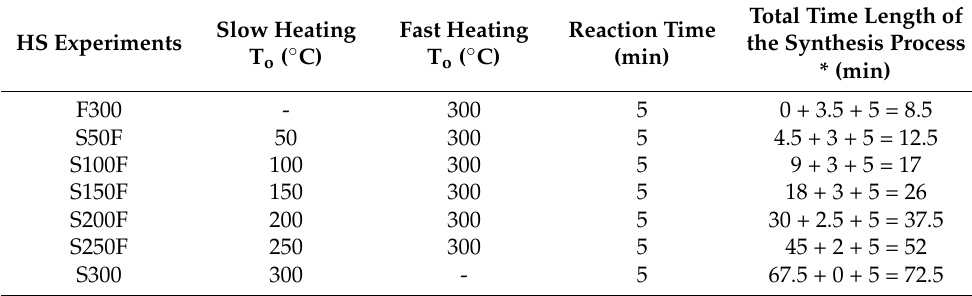
Table 1. Nomenclature of the samples and their corresponding experimental conditions. All the samples were heated up to 300 ◦ C and subjected to 110 bars of